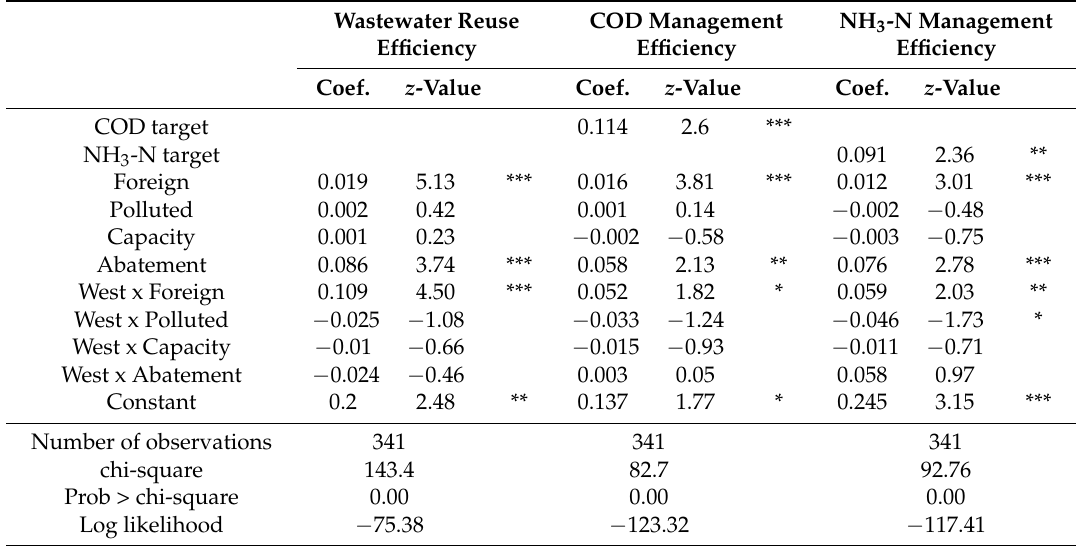
Table 3. Results of the determinant analysis of wastewater management